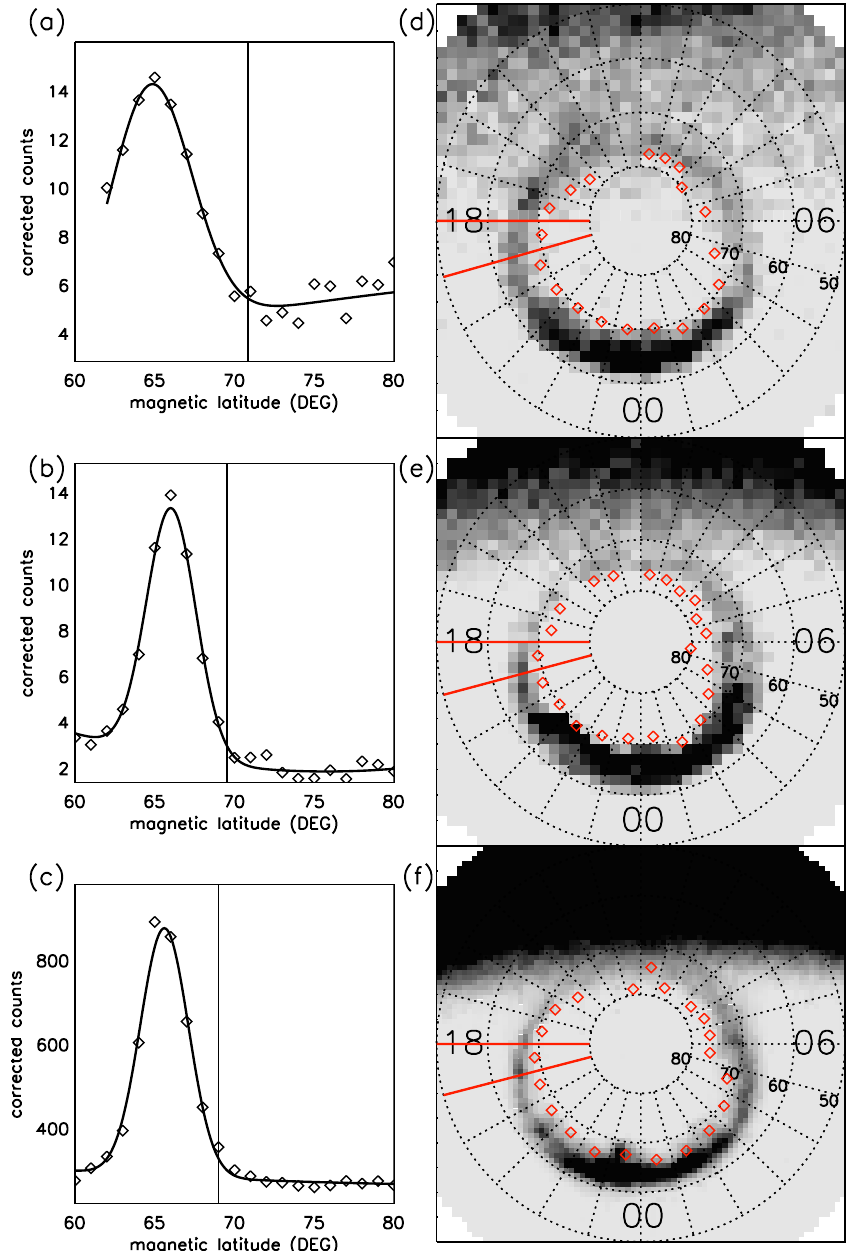
Fig. 1. (a–c) Intensity-latitude profiles (left-hand column) across a 1h MLT sector (18:00–19:00MLT) and (d–f) images of the auroral oval (right-hand column), with magnetic local noon at the top of the figure, for 20:40:09 on 26 December 2000. Rows correspond to data from three different IMAGE FUV detectors, SI-12 (top), SI-13 (middle) and WIC (bottom). Average intensities in bins of one degree magnetic latitude are shown by diamonds and the Gaussian plus quadratic background fits to these points are shown by the solid curves. The position of the OCB proxies are marked by the vertical solid lines and overplotted on the auroral images by red diamonds.